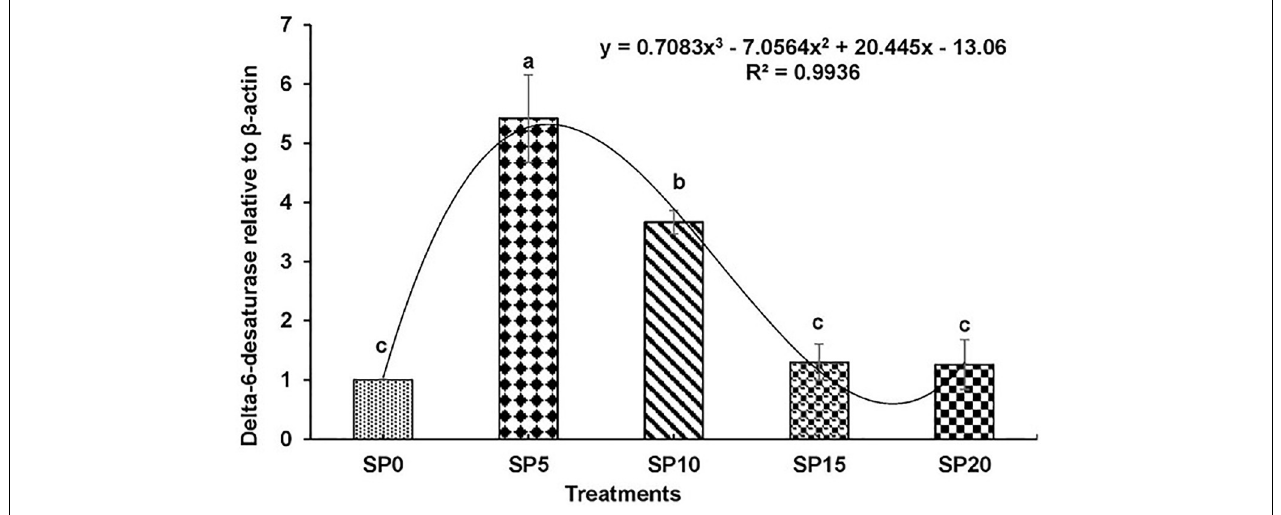
FIGURE 1 | Expression of delta-6-desaturase ( fads2d6) relative to β -actin in hepatopancreas of five different diet-fed Cyprinus carpio . Bars with different superscripts are significantly different ( n = 3). A polynomial (order 3) relationship was found between the diet and expression of fads2d6 ( R 2 = 0.994).